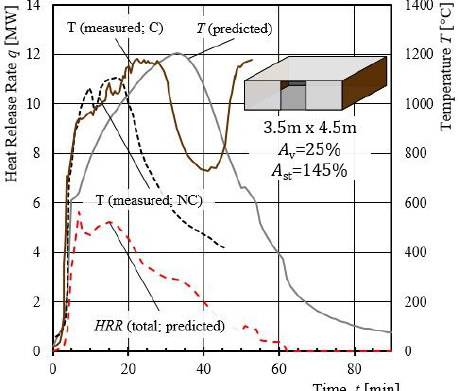
Figure 21: Predicted and measured temperatures for the predicted total HRR for experiment